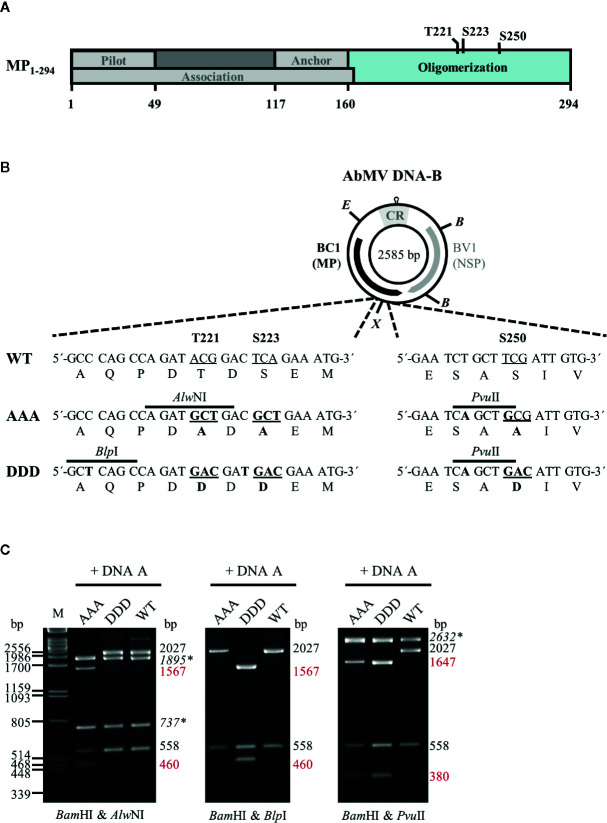

(A) Schematic overview of previously described functional regions and phosphorylation sites identified within full-length AbMV MP (Zhang et al., 2001; Frischmuth et al., 2004; Kleinow et al., 2009b; Krenz et al., 2010; Krapp et al., 2017). (B) Schematic representation of the organization of DNA-B encoding the movement protein (MP; BC1) and the nuclear shuttle protein (NSP; BV1). Eco RV (E) and Xba I (X) sites used for cloning of DNA-B versions with triple phosphorylation site mutations [T221, S223, and S250 exchanged against alanine (AAA) or aspartate (DDD)] for MP are indicated. Details of the site-directed mutagenesis (nucleotide and amino acid changes shown in bold) and newly introduced mutagenesis-specific restriction sites are depicted below. CR: common region; B: Bam HI (C) Representative RCA-RFLP analysis using Bam HI combined with either of the mutagenesis-specific restriction enzymes to monitor the presence of DNA-A and DNA-B variants within total nucleic acids from infected plants (Kleinow et al., 2009b). Sizes of expected fragments are indicated. DNA-A-derived fragments are labelled (italics and asterisks), with those specifically originating from mutagenesis within BC1 displayed in red. RCA-RFLP analysis was carried out for all samples out of the experiments listed in
Tables 1
 and
2
.